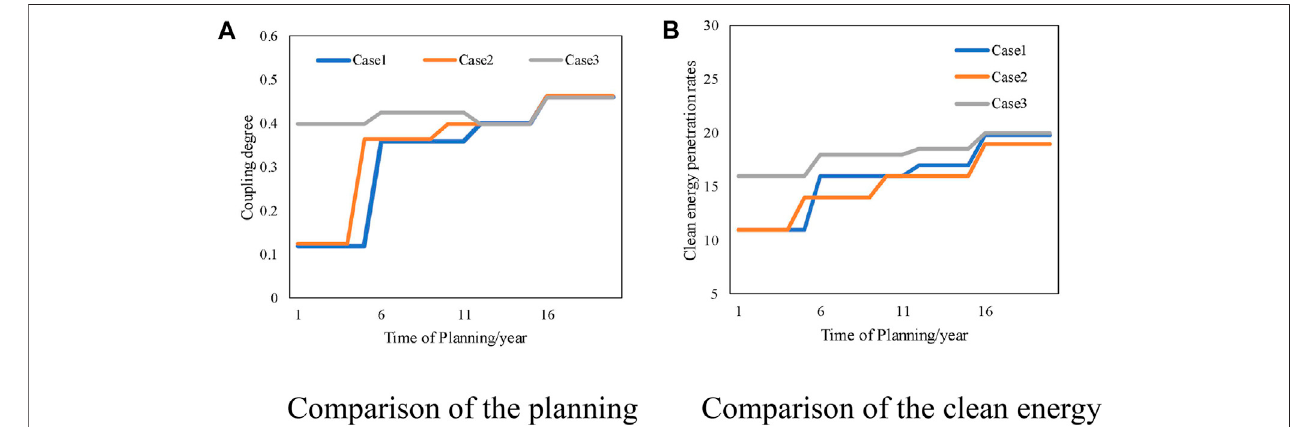
FIGURE 10 | Comparison of the planning performance.